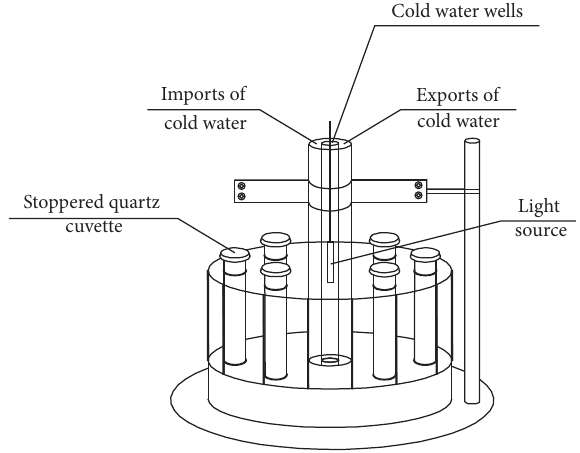
Figure 1: Rotating photochemical reactor